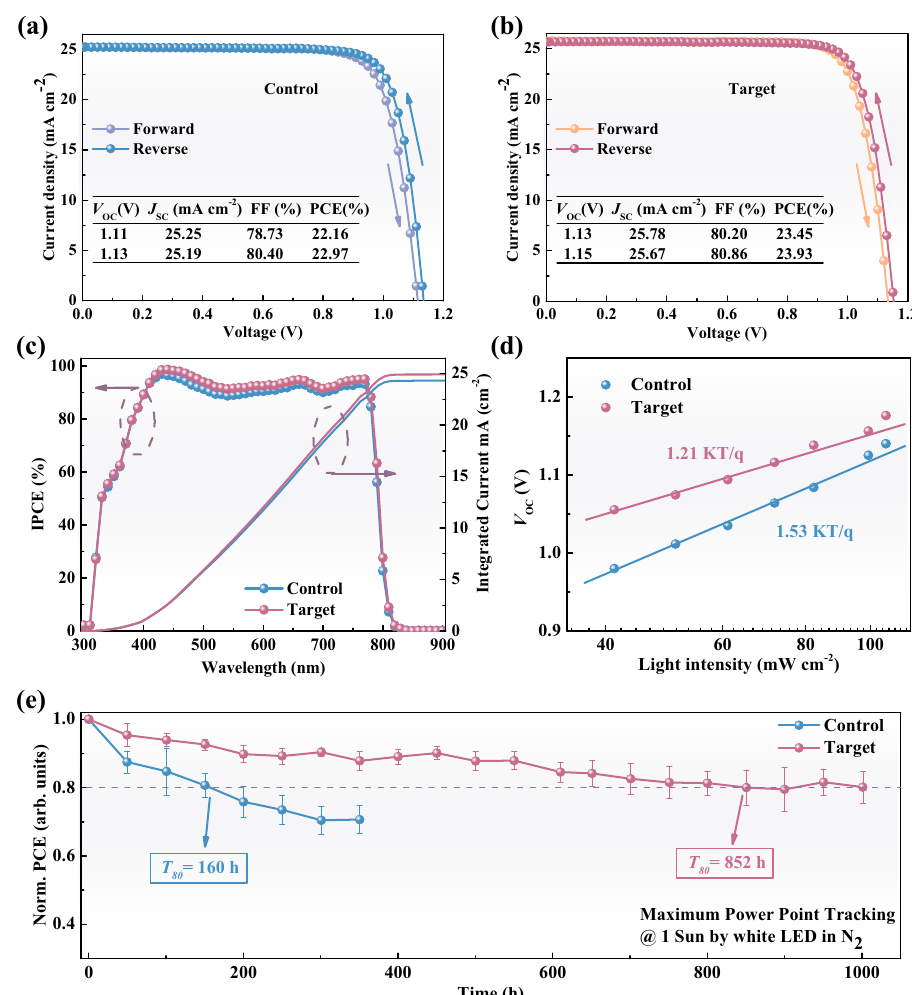
Fig. 5 | Photovoltaic characterization of the devices based on the control and targetperovskite fi lms.a , b J-V curvesandphotovoltaicmetricsunderreverseand forward scans. c IPCE spectra and the corresponding integrated J SC of the control and the target PSCs. d Dependency of V OC as a function of the incident light